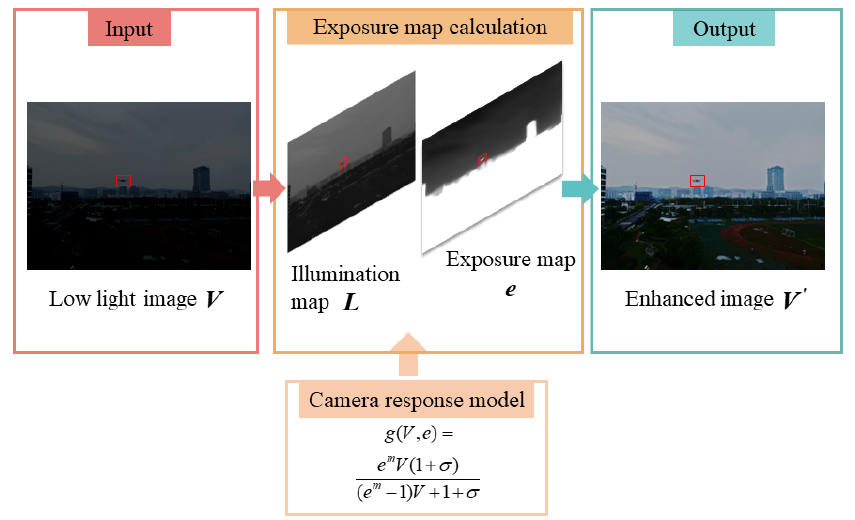
Figure 4. Pipeline of the proposed image enhancement